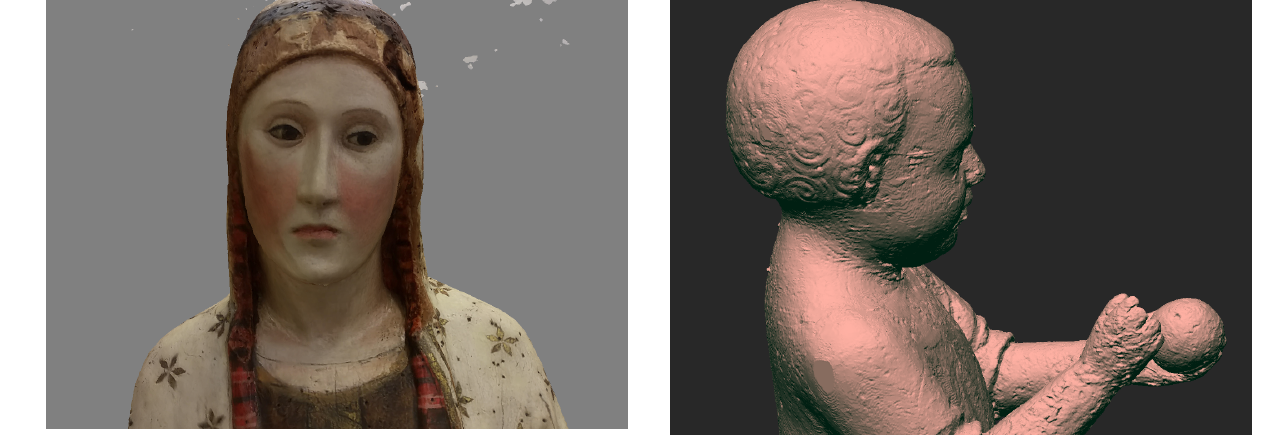
Figure 7: Textured image based model